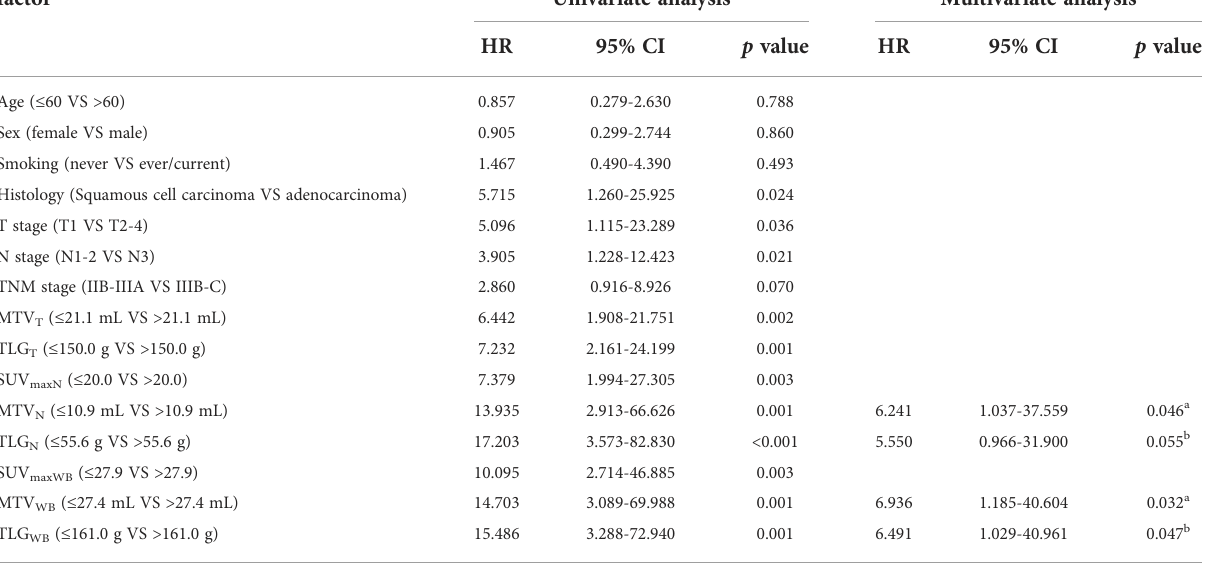
TABLE 3 The risk factors of brain metastases development.